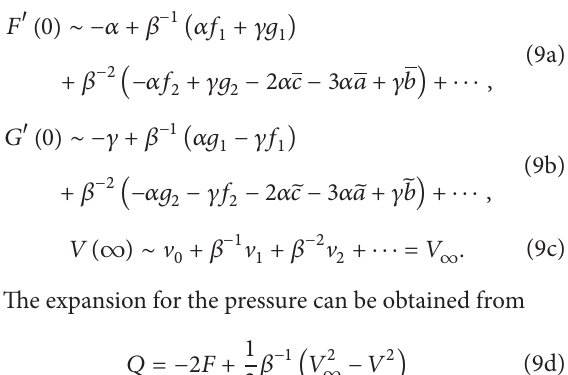
Solid lines ≡ numerical Markers ≡ asymptotic